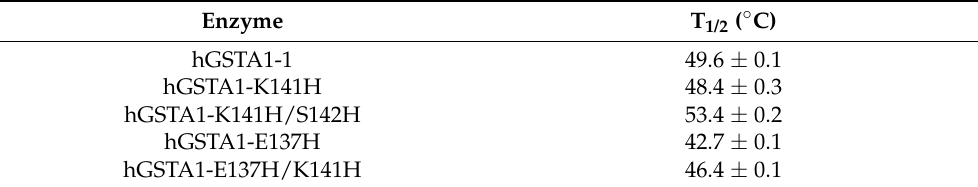
Table 4. Thermal stability of hGSTA1-1 and its mutants. Reported values represent the average of three replicates. Enzyme